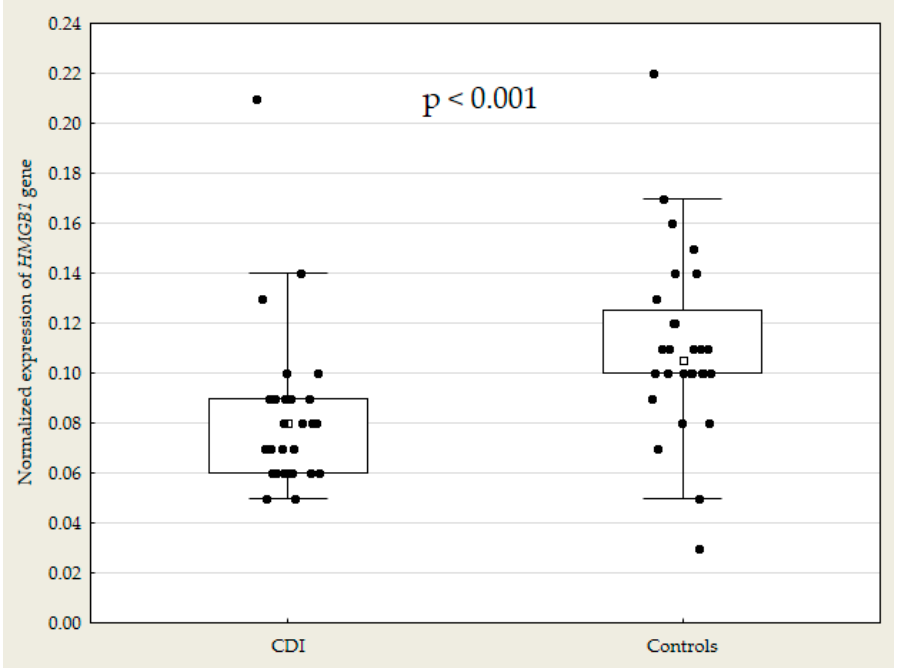
Figure 1. Normalized expression of HMGB1 gene in CDI ( n = 27) and control ( n = 28) groups. Box represents 25th and 75th percentile of values with median values marked within the boxes. Whiskers represent 5th–95th percentile. CDI, Clostridioides difficile infection; HMGB1 , high- mobility group box 1.